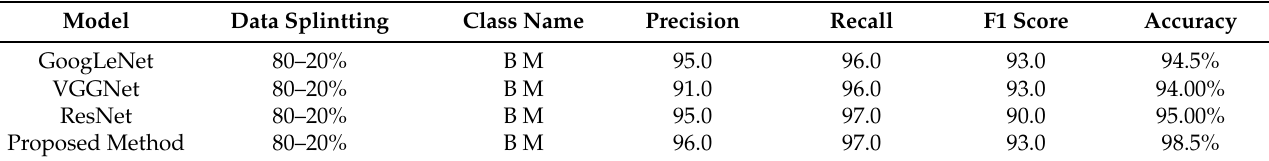
Table 1. Using data splitting, we compared the proposed framework to several CNN architectures.